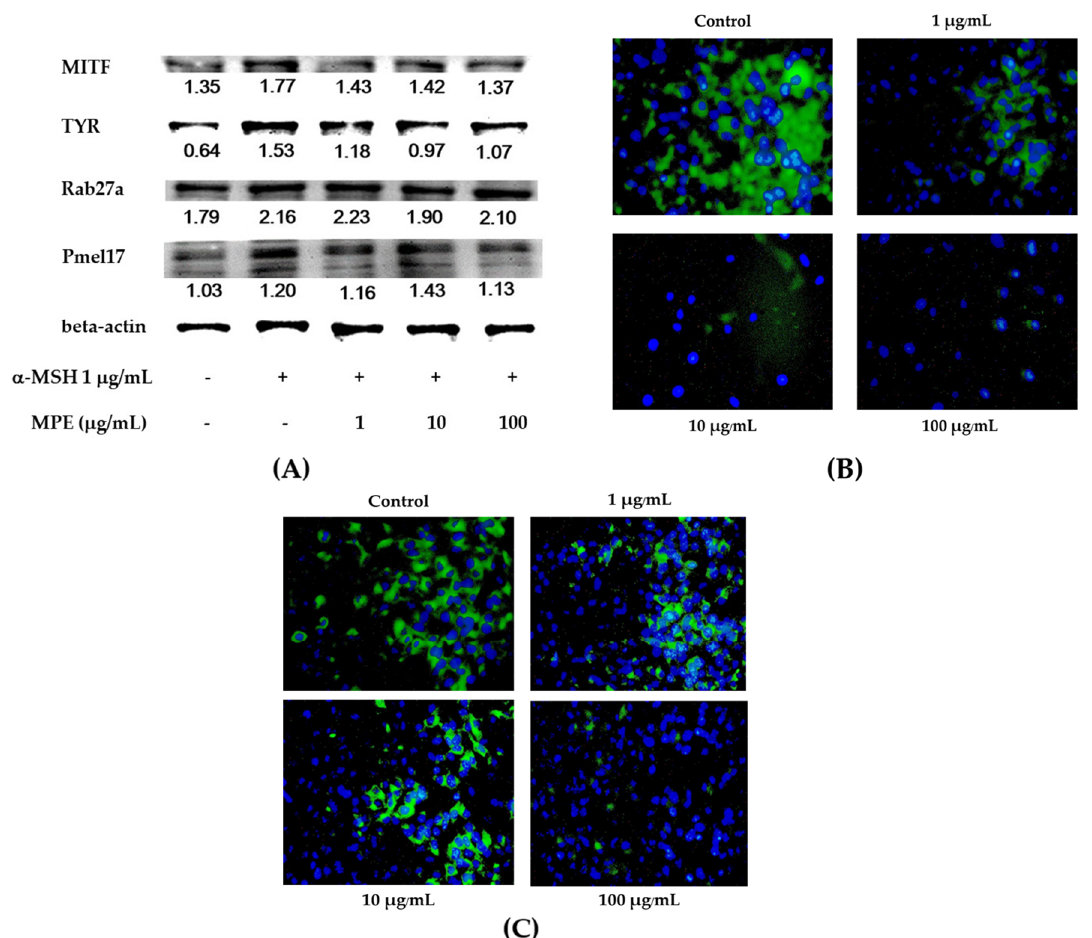
Figure 3. Effects of MPE on melanosome transfer (Rab27a and Pmel17). ( A ) The protein expression levels after MPE treatment. MITF protein expression (mean ± SD, n = 4). Tyrosinase protein expression (mean ± SD, n = 4). Rab27a protein expression (mean ± SD, n = 3). Pmel17 protein expression (mean ± SD, n = 4). ( B ) Localization of Rab27a and ( C ) Pmel17 proteins in B16F10 cells using immunofluorescence analysis. Confocal images were obtained using an Olympus CKX41 Fluorescence microscope.